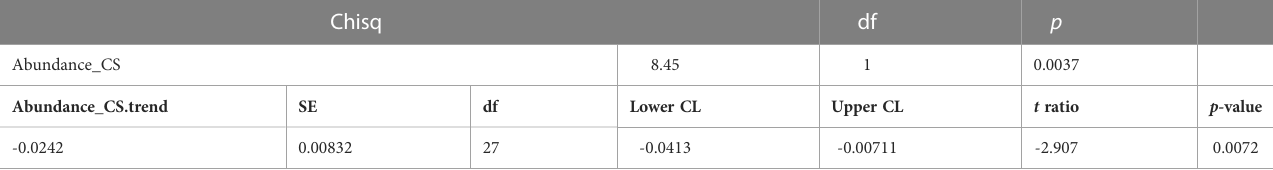
TABLE 3 Upper part: Chisq, degrees of freedom, and p ‐ values for the sub-site model.